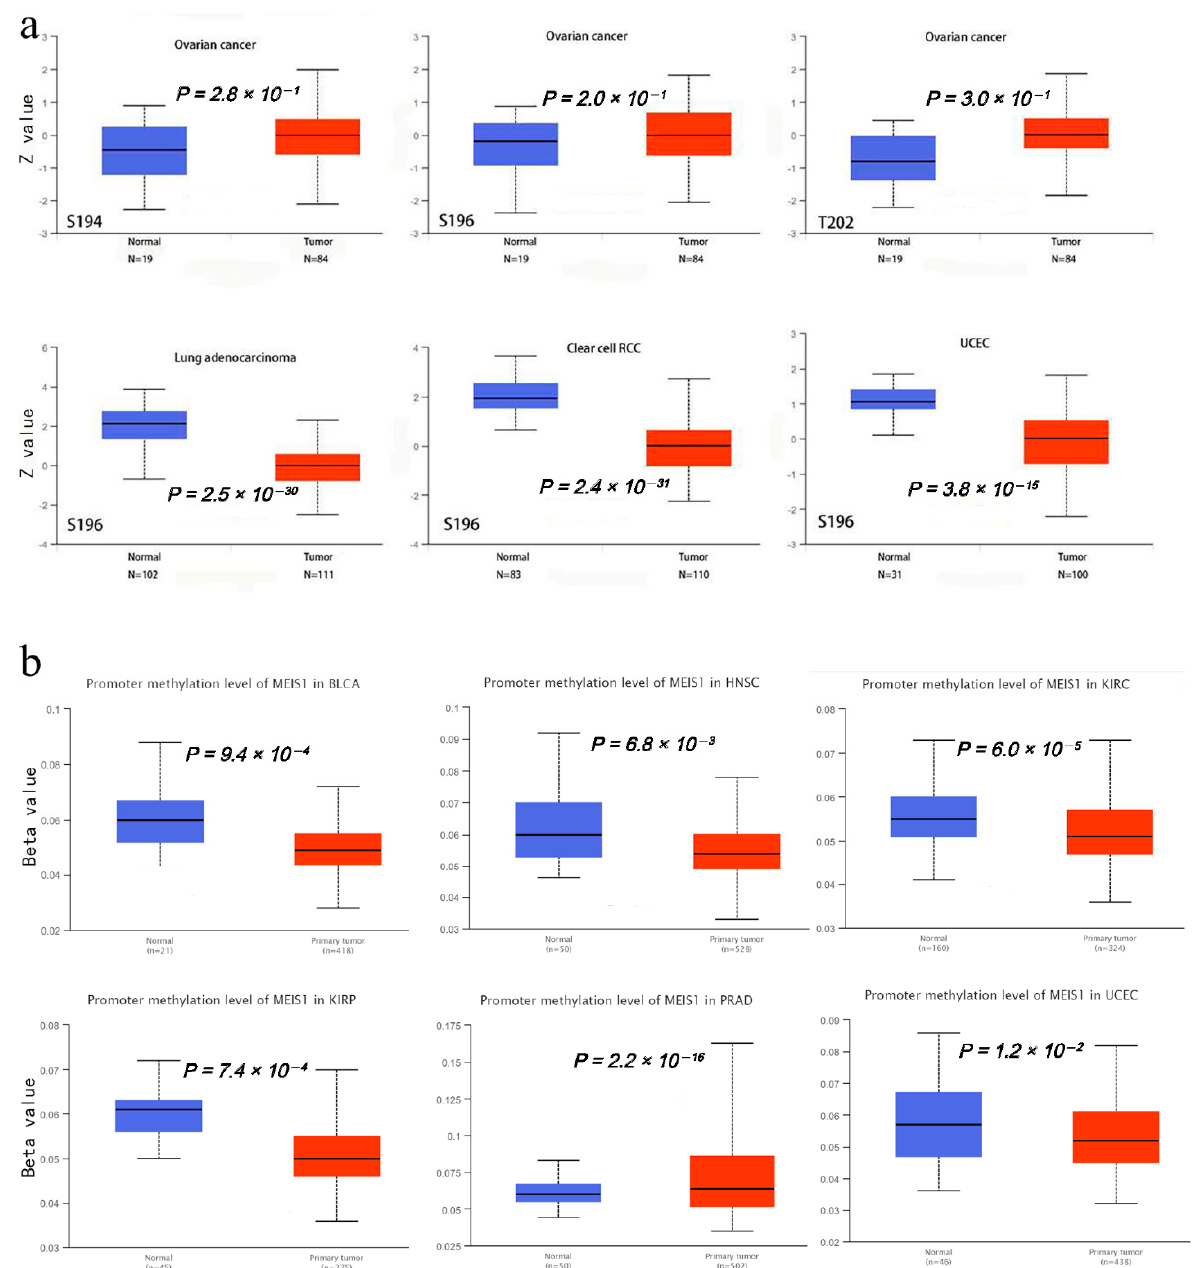
Figure 4. Phosphorylation and promoter methylation analyses of MEIS1 protein in different tumors. ( a ) Phosphorylation level of MEIS1 between their tumor tissues and normal tissues. ( b ) Promoter methylation level of MEIS1 between their tumor tissues and normal tissues.